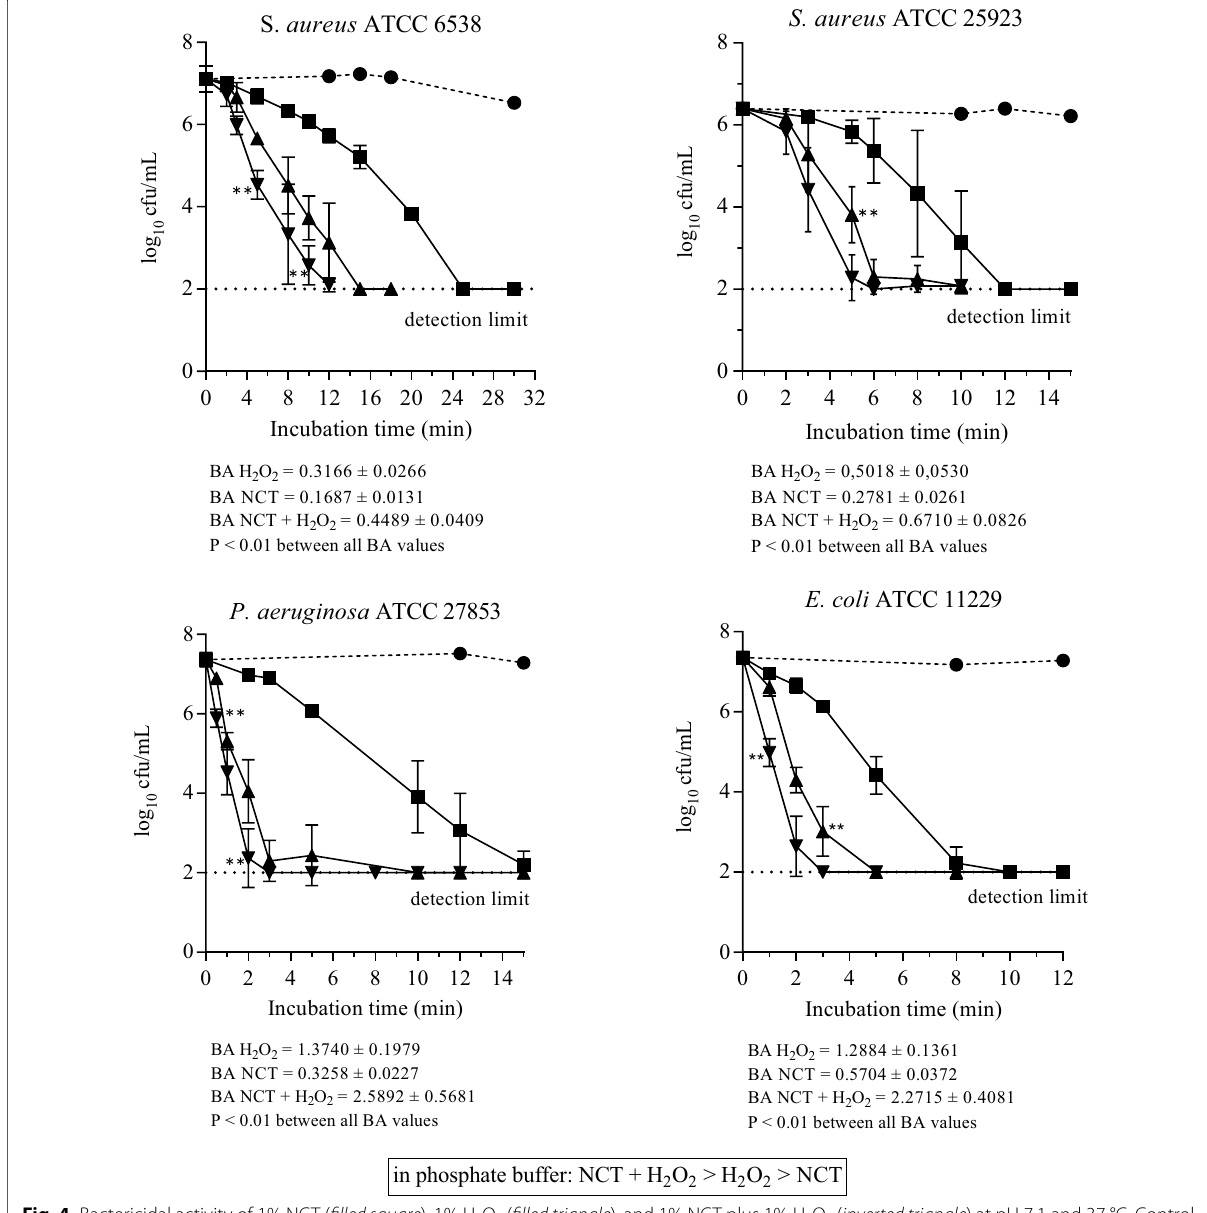
Fig. 4 Bactericidal activity of 1% NCT ( filled square ), 1% H 2 O 2 ( filled triangle ), and 1% NCT plus 1% H 2 O 2 ( inverted triangle ) at pH 7.1 and 37 °C. Control in phosphate buffer without additives ( filled circle ). Mean values SD of three to four independent experiments. ** P < 0.01 versus all other values. ± BA “bactericidal activity” [log 10 cfu/min] as a quantitative measure for the strength of killing calculated by the integral method for the whole killing curve according to (Gottardi et al. 2015). The higher the value, the higher the microbicidal